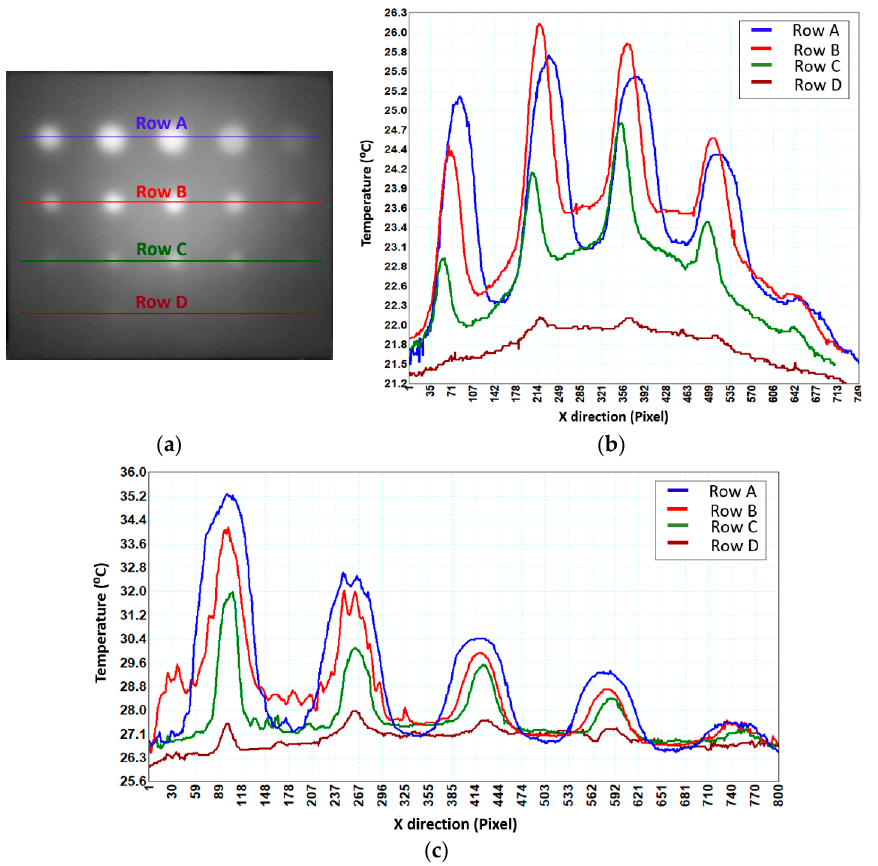
Figure 5. ( a ) Positions of temperature profiles. Temperature profiles using ( b ) pulsed and ( c ) step heating thermography. The rows are identified in ( a ).